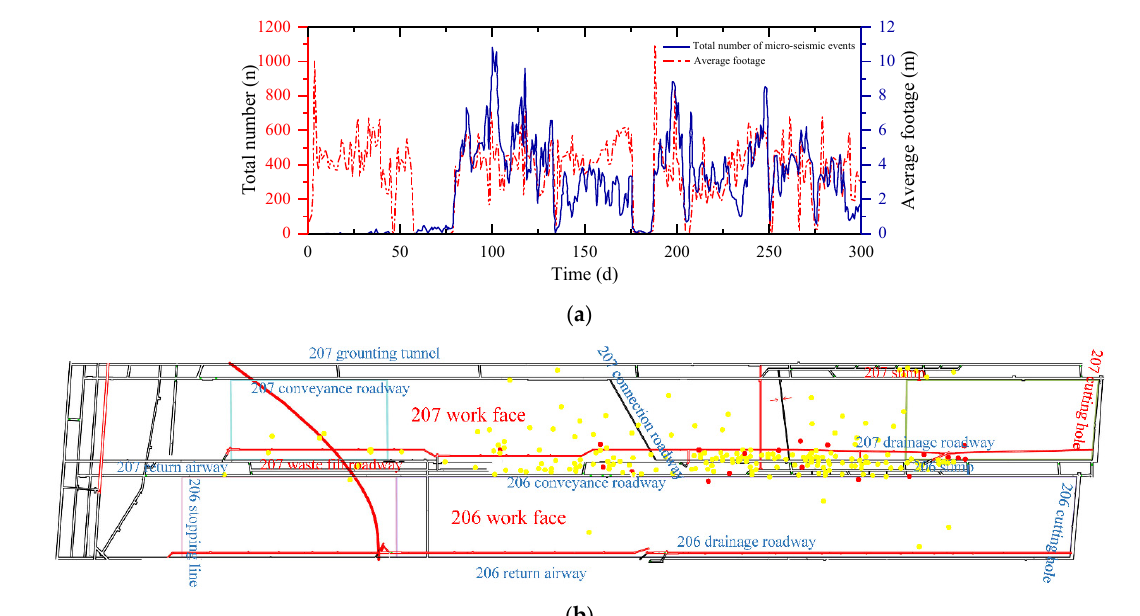
Figure 11. Micro-seismic monitoring data at 207 working face. ( a ) The number of micro-seismic events varies with daily footage, ( b ) source location distribution of micro-seismic